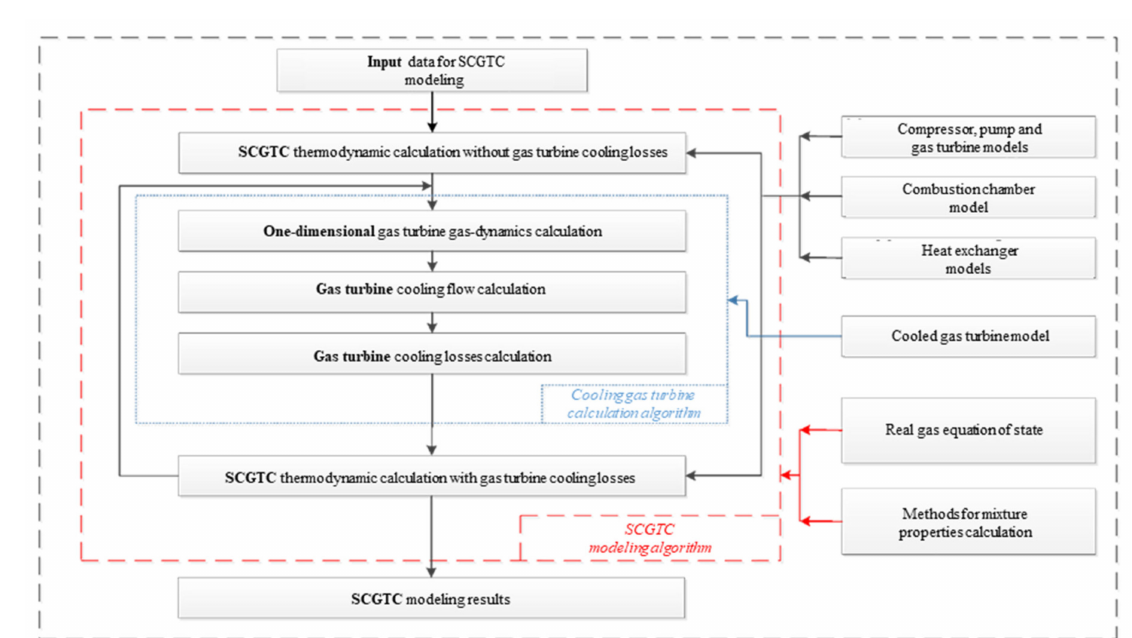
Figure 5. Semiclosed gas turbine cycle simulation